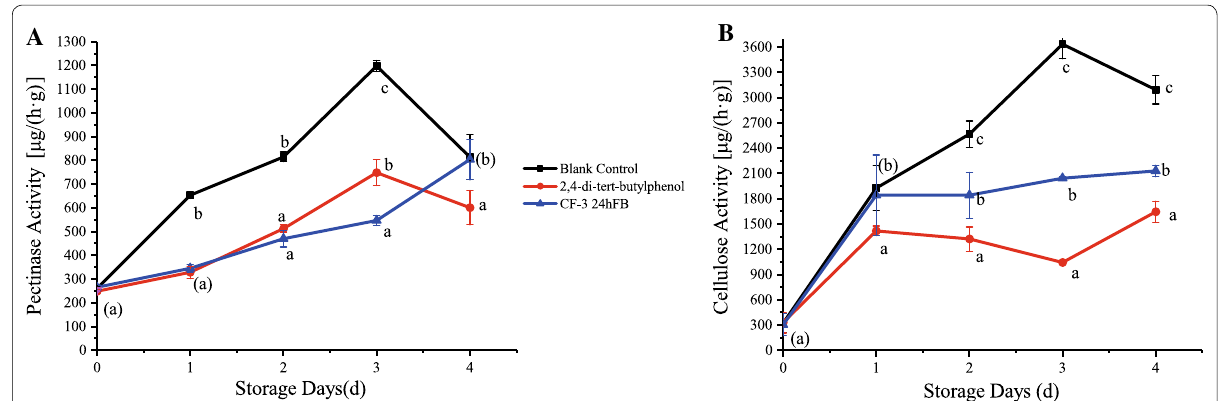
Fig. 3 Influence of different treatments on pectinase ( A ) and cellulase ( B ) activity in vivo during storage. The mean and standard error in the figure were taken from three replicates, and different letters indicate that different treatments on the same storage days were significantly different ( P < 0.05 )